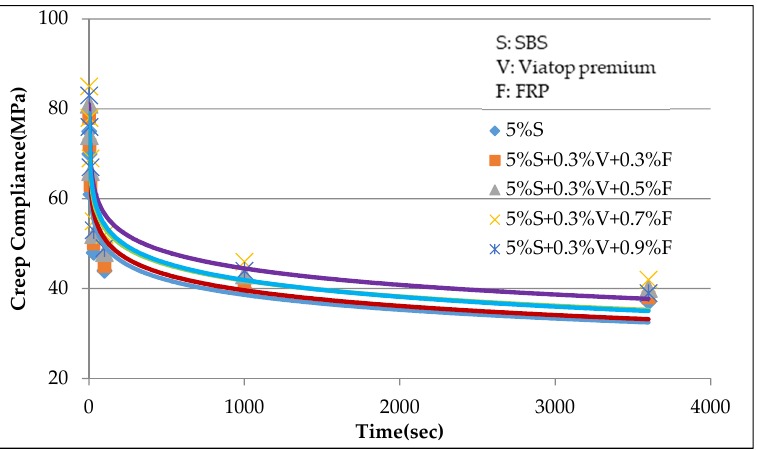
Figure 12. Deformation-Load Repetition.